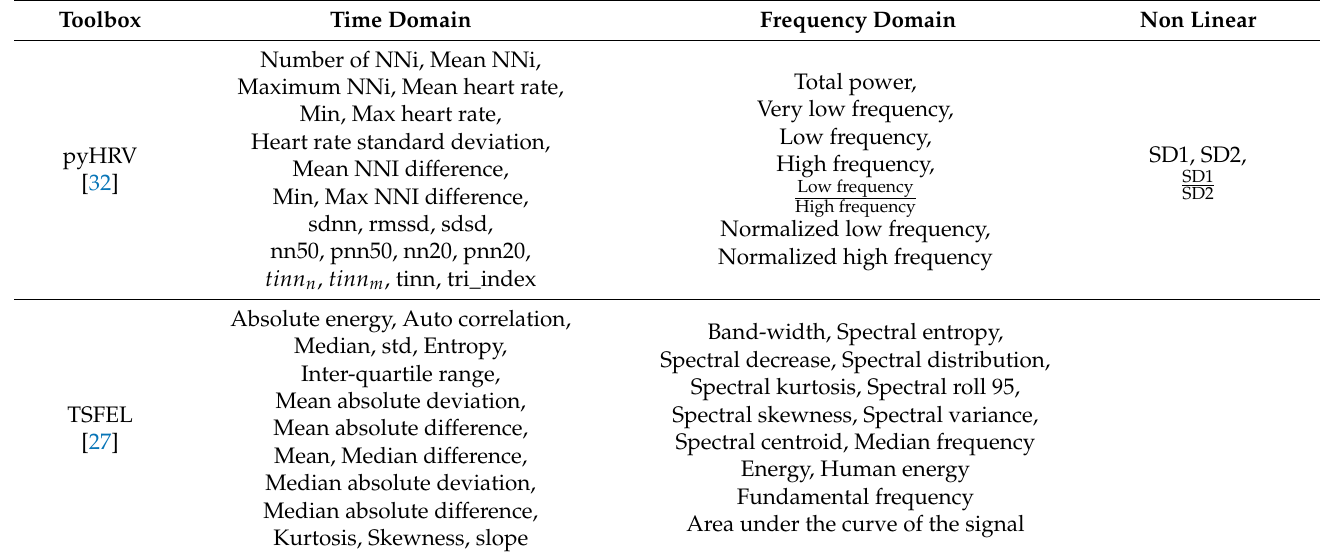
Table 1. List of computed HRV features.